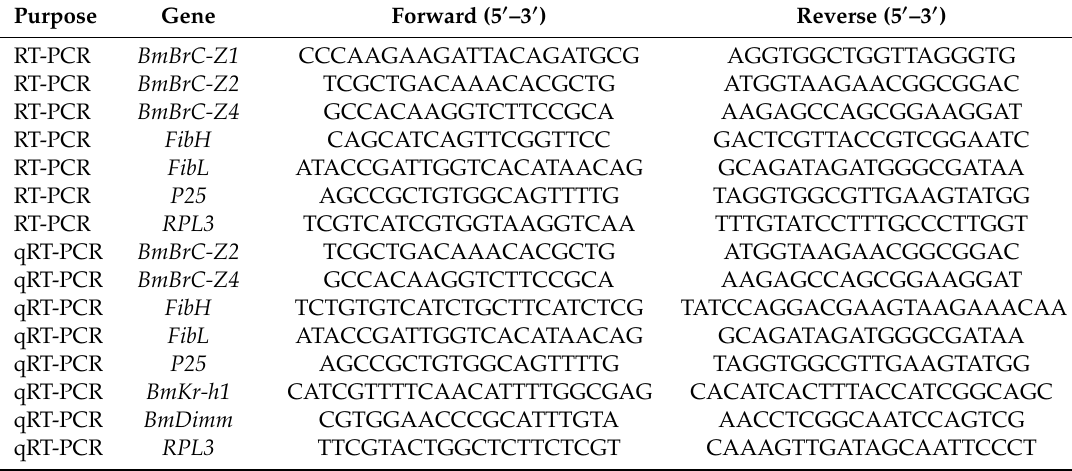
Table 1. Primers used in the semi-RT-PCR and quantitative